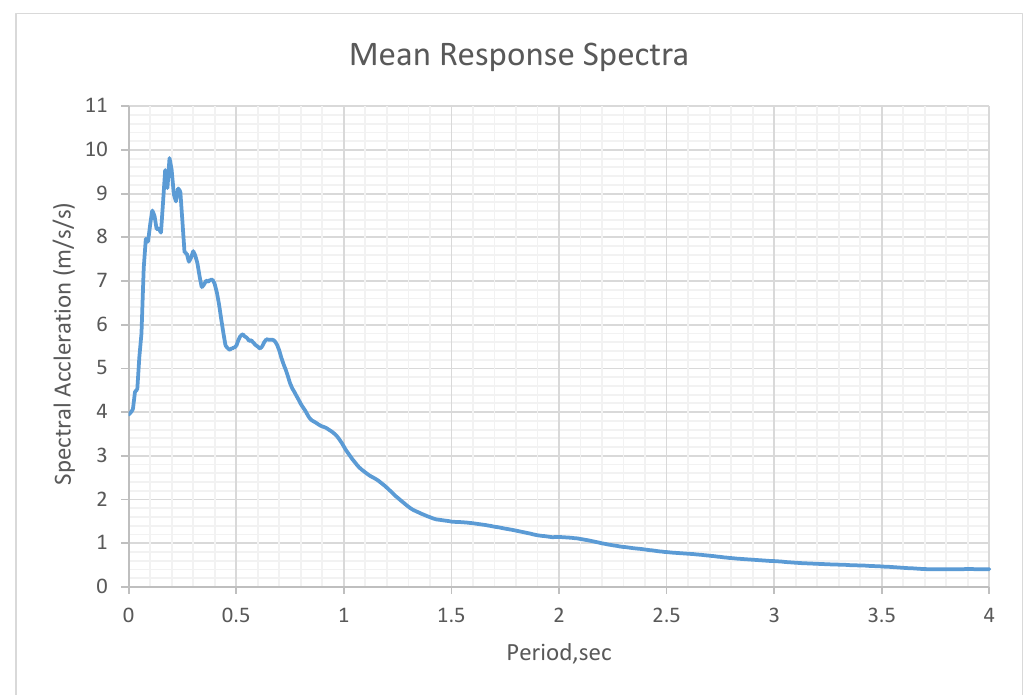
Fig. 5. Average response spectra of the selected and scaled accelerograms to gravity acceleration (9.81 m/s 2